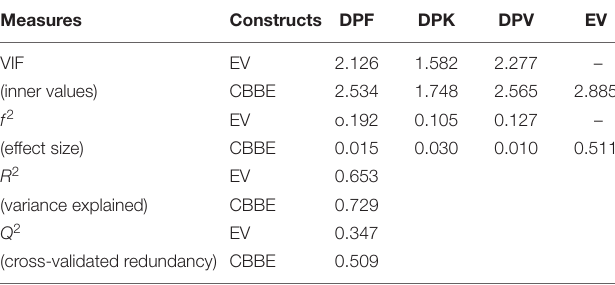
TABLE 4 | Model’s predictive